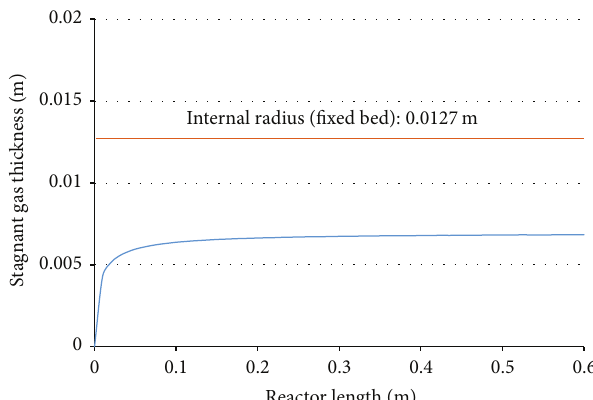
Figure 5: Profile of the stagnant gas layer in the fixed bed.